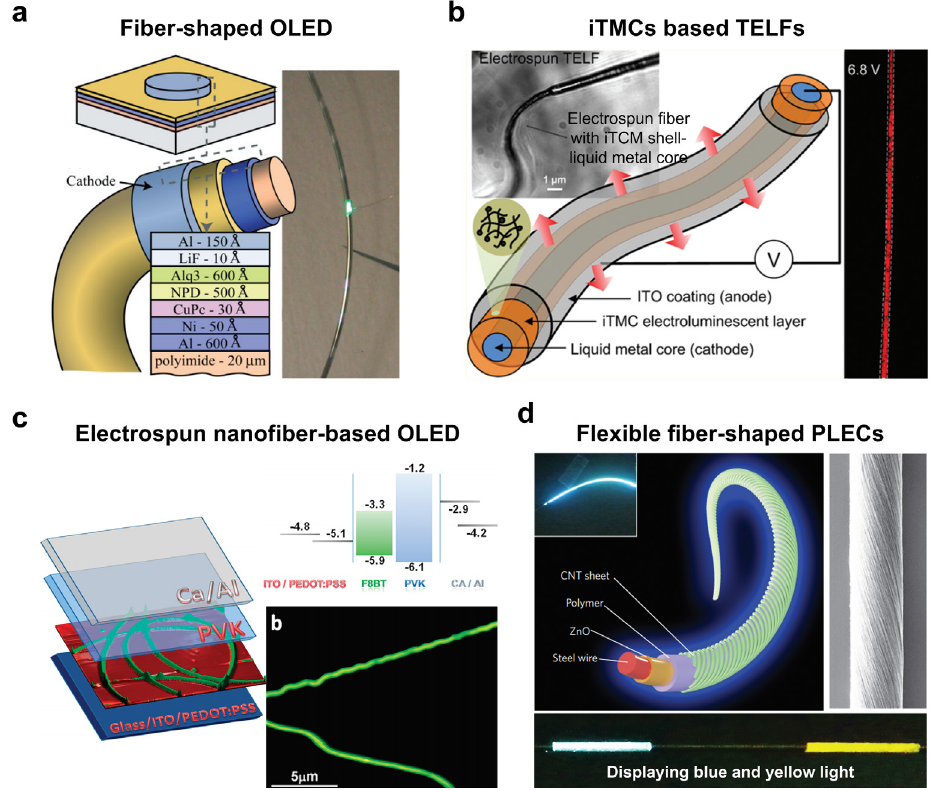
Figure 6. ( a ) Schematic illustration of a fiber-shaped organic light emitting diodes (OLED) structure compared with a typical OLED structure and a photograph of a flexed fiber with a green light-emitting pixel; ( b ) Schematic illustration and optical image of ionic transition-metal complex (iTMCs)-based electro-luminescent nanofibers (TELFs) fabricated via coelectrospinning and luminescence response of TELF under an applied voltage of 6.8 V; ( c ) Schematic of the conjugated polymer electrospun nanofiber-based OLED structure (left), energy level diagram (right top), and fluorescence microscopy image of an electrospun nanofiber, F8BT-PEO (right bottom); ( d ) Schematic illustration showing the structure of flexible fiber-shaped polymer light-emitting electrochemical cells (PLECs). Left inset: photograph of a fiber-shaped PLEC biased at 10 V, right inset: aligned CNT sheet wrapped around the modified stainless steel wire, and bottom inset: PLEC displaying blue and yellow light. Reproduced from [42,43,134,135] with permissions by John